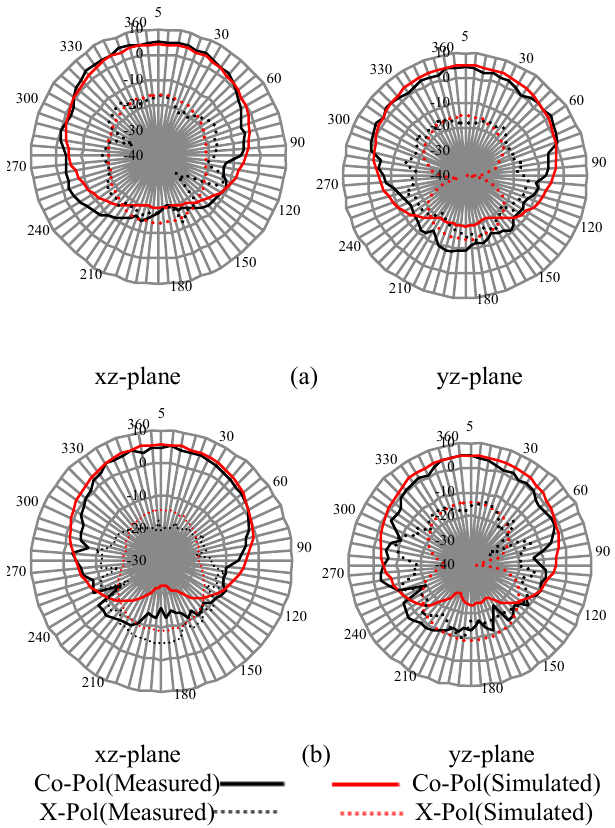
Figure 7: Simulated and measured 2-D radiation patterns at 2.37 GHz (a) LHCP state (b) RHCP (State)